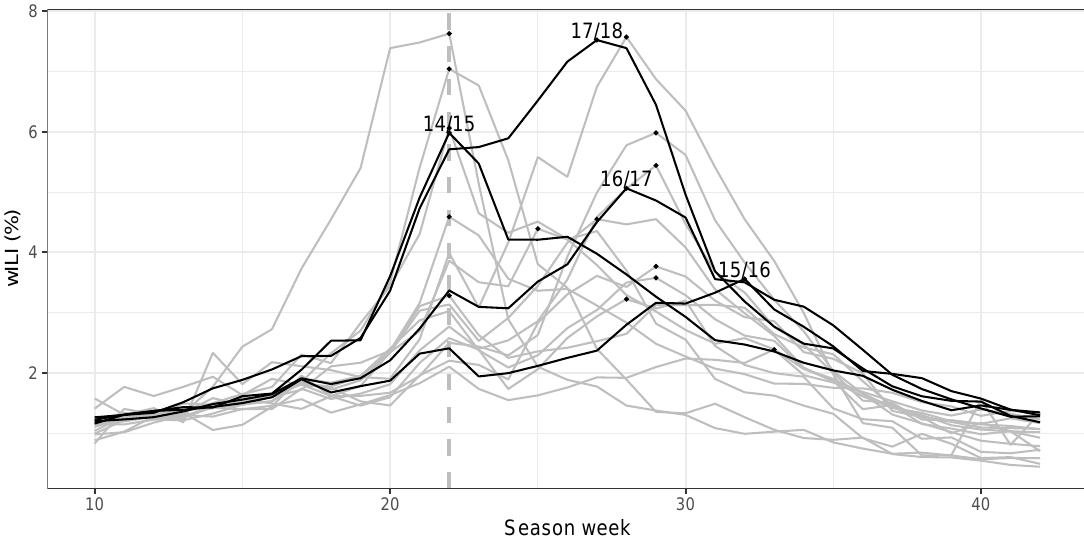
Figure 2. Weighted influenza-like illness (wILI) in the USA for flu seasons 1998 through 2017. The pandemic seasons are excluded. Season week 22 is indicated with a vertical dashed line, where a peak or secondary peak occurs in most seasons. Data in the training and test seasons are in gray and black, respectively. The peak of each season is indicated by a